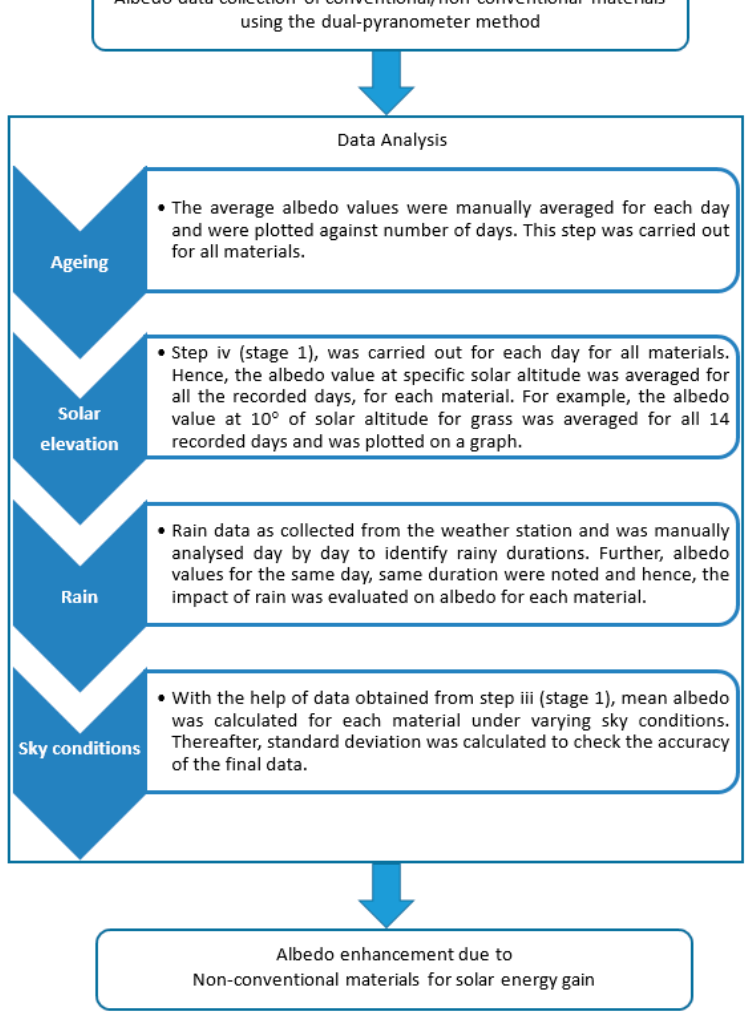
Figure 1. Data collection and analysis sequence.